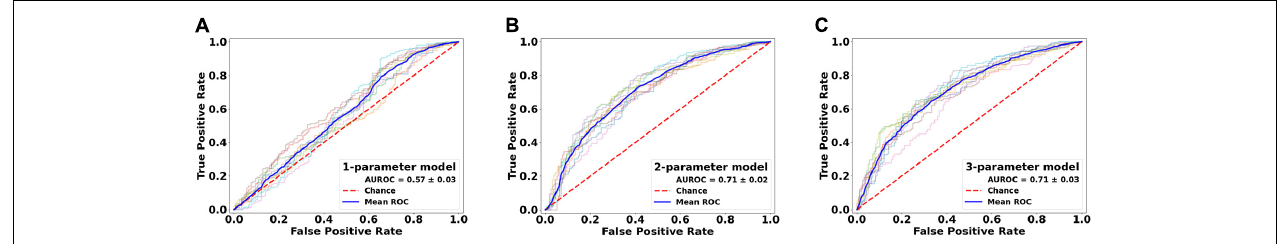
FIGURE 6 | Performance comparison of the classification models in lesion versus NAWM analysis. Shown are the ROC curves for models constructed from the top three ranked diffusion features: (A) orientation distribution function (ODF) energy alone, (B) ODF energy + fractional anisotropy (FA), and (C) ODF energy + FA + orientation dispersion index. ROC, receiver operating characteristics; AUROC, area under the ROC curve.